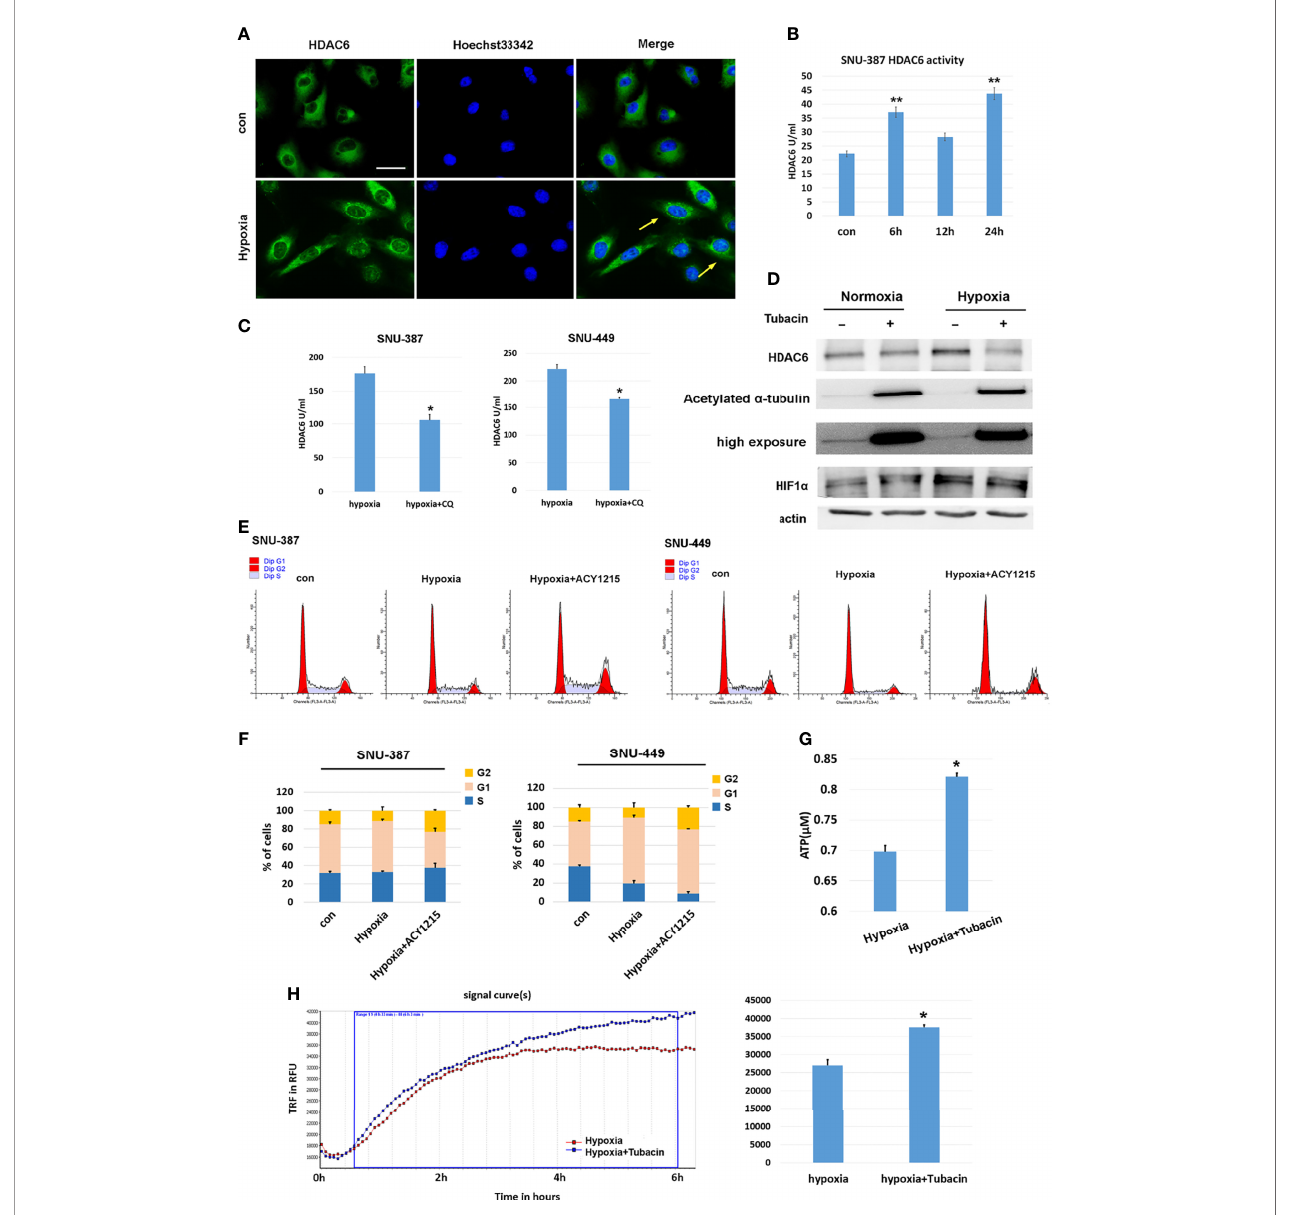
FIGURE 2 | HDAC6 inhibition increased mitochondrial respiration and suppressed hypoxia-induced proliferation features of HCC cells. (A) Immuno fl uorescence staining for HDAC6 in SNU-449 cells under normoxic or hypoxic conditions. Scale bar = 60 m m. (B) The activity of HDAC6 was measured in SNU-387 cells (means ± SD, n = 3, ** P < 0.01). (C) SNU-387 and SNU-449 cells were treated with CQ and the activity of HDAC6 was measured (means ± SD, n = 3, * P < 0.05). (D) SNU-449 cells treated with tubacin for 6h and total cell lysates were subjected to western blot analysis as indicated. (E, F) SNU-387 and SNU-449 cells were treated with ACY-1215 for 24h and propidium iodide staining was used for cell cycle was analysis. (G) SNU-449 cells were treated with tubacin for 24h under hypoxia and the production of ATP was evaluated (means ± SD, n = 3, * P < 0.05). (H) Measurement of OCR in SNU-387 cells treated with Tubacin for 6h under hypoxic